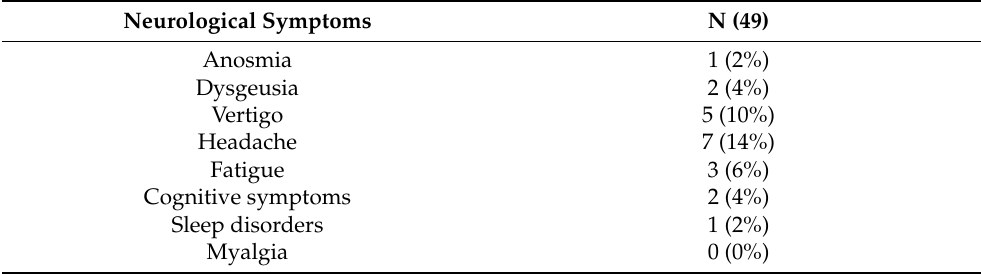
Table 4. Neurological symptoms 300 days after onset of COVID-19 infection.